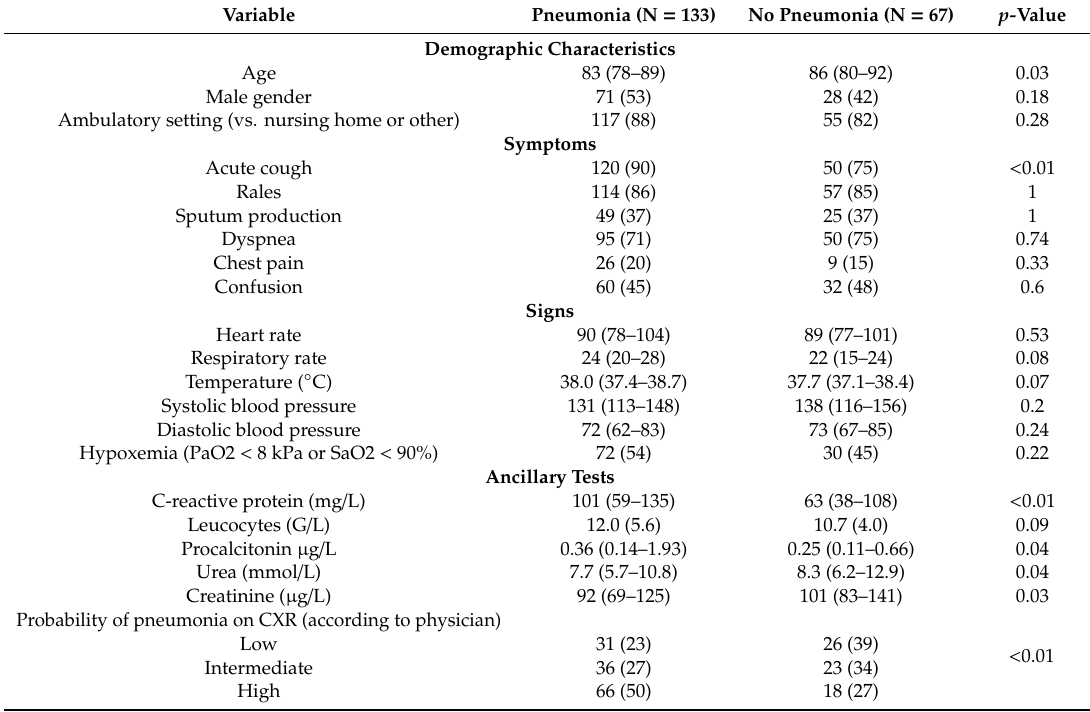
Table 1. Univariate association between demographic, clinical, biological and radiological variables, and final diagnosis of